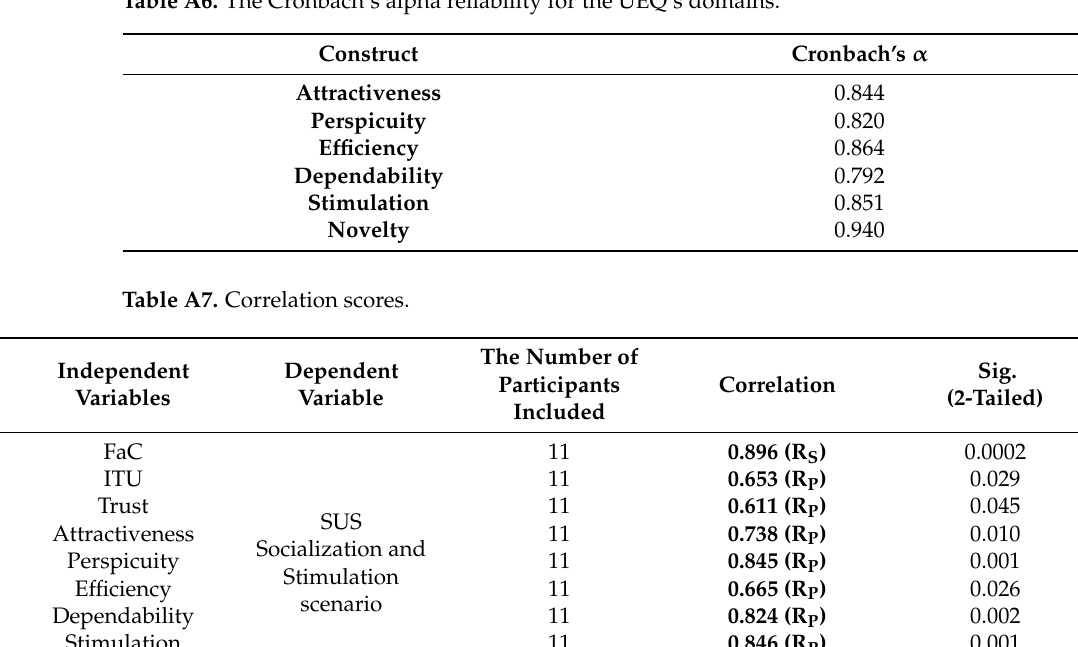
Table A6. The Cronbach’s alpha reliability for the UEQ’s domains.